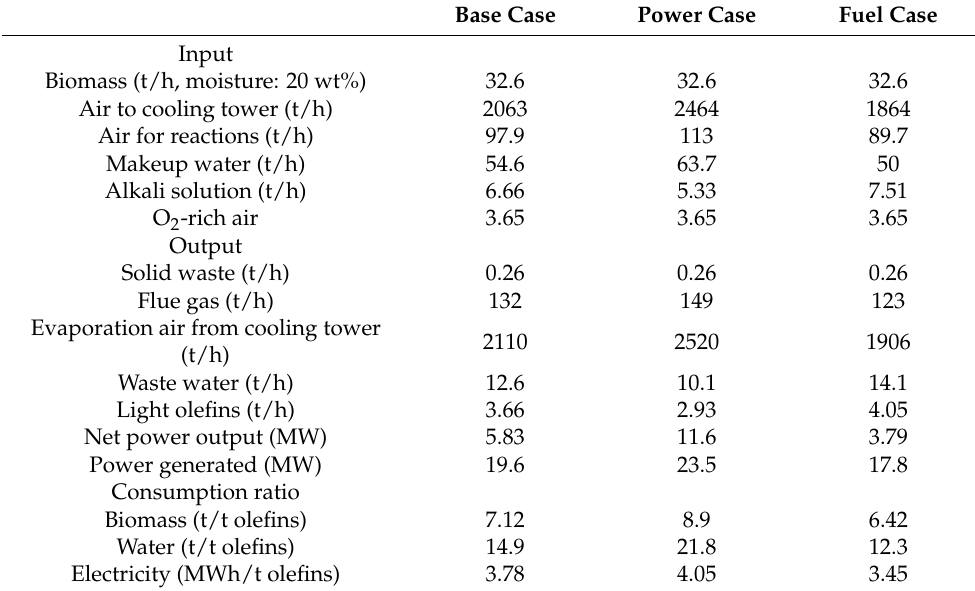
Table 4. Overall mass balance of designed biomass-olefin system with a